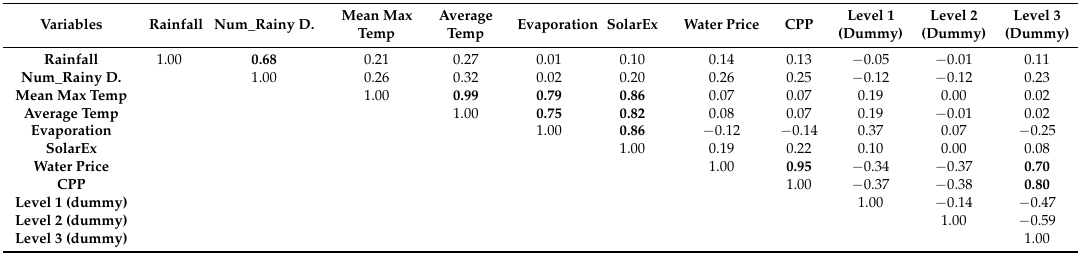
Table 2. Pearson correlation matrix of the independent variables.